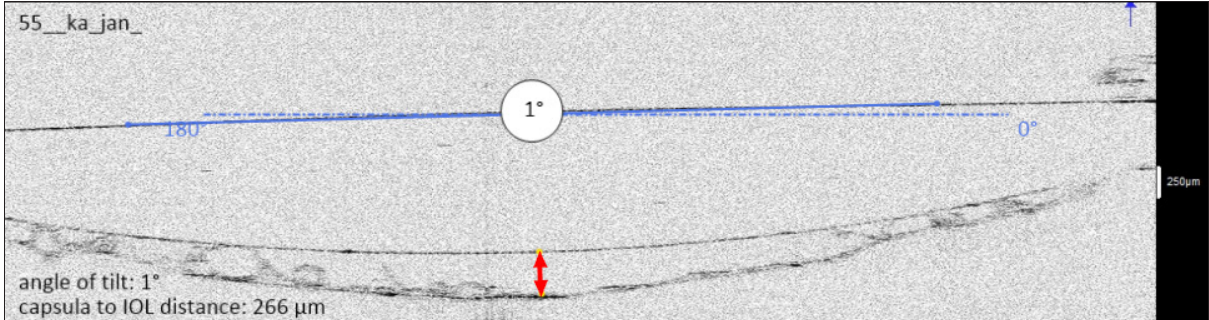
Fig. 1. OCT image of IOL in the eye with posterior capsule opacification. The angle of tilt is equal to 1° from horizontal plane, red arrow present distance from posterior plane of IOL to posterior capsule (LCD) which is equal to 266 µm.